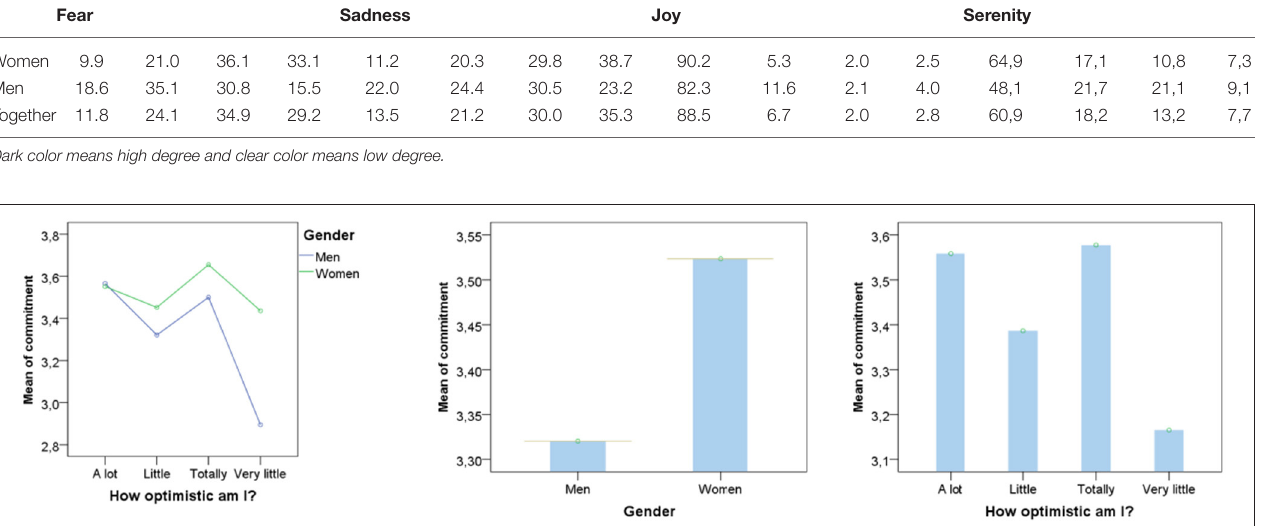
TABLE 4 | Percentages of women and men regarding the four degrees of fear, sadness, joy, and serenity (percentages). Degree